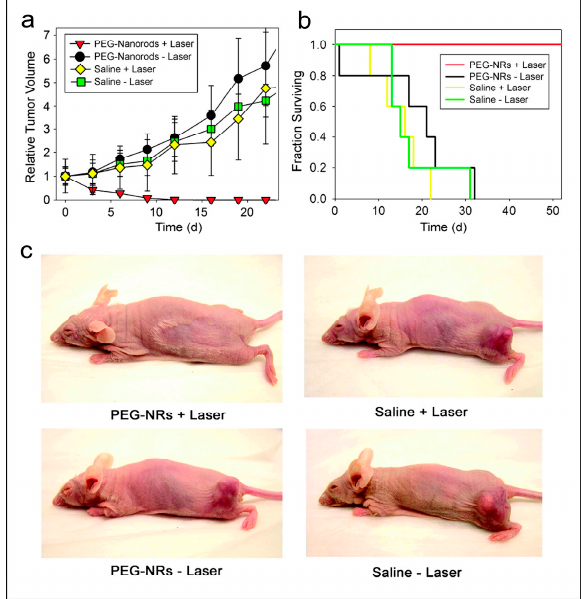
Figure 1. Photothermal destruction of mice bearing MDA-MB-435 human tumors with polyethylene glycol (PEG)-gold-nanorods (PEG-NRs). ( a ) volumetric changes in tumor sizes over time after irradiation. Mice with two human tumors on opposite flanks were injected with either saline or PEG-NRs. The right flank of each mouse was exposed to computationally designed irradiation regimen (810 nm, 2 W/cm 2 , 5 min); ( b ) survival of mice over time after irradiation. Mice with one human tumor were injected with either saline or PEG-NRs and irradiated as in ( a ); ( c ) at 20 days after irradiation, all PEG-NR ejected mice showed no evidence of tumor regrowth while all other treatment groups harbored thriving tumors. Reproduced with permission from ref. [50].